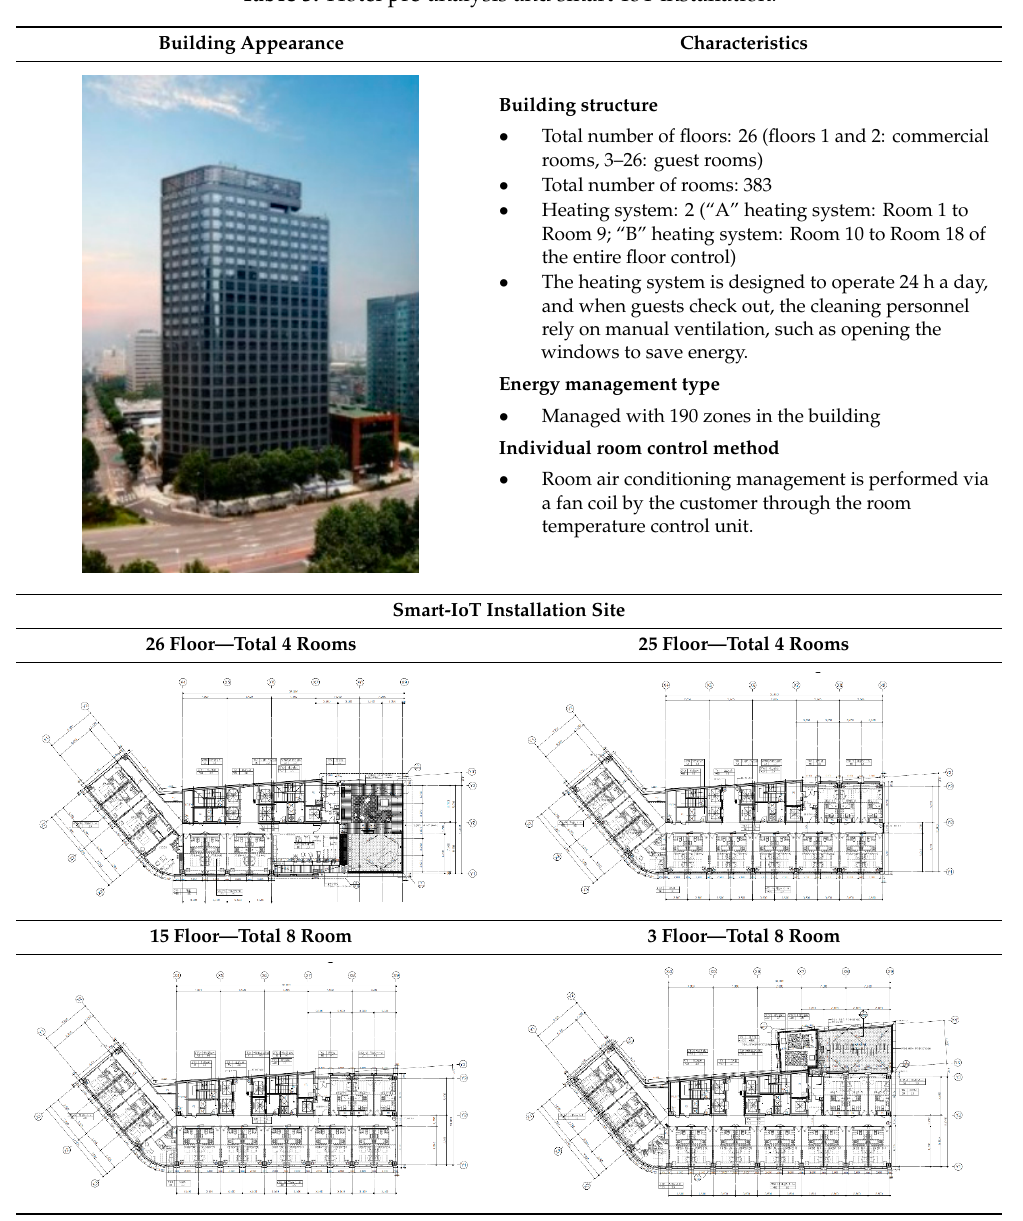
Table 3. Hotel pre-analysis and smart-IoT installation.